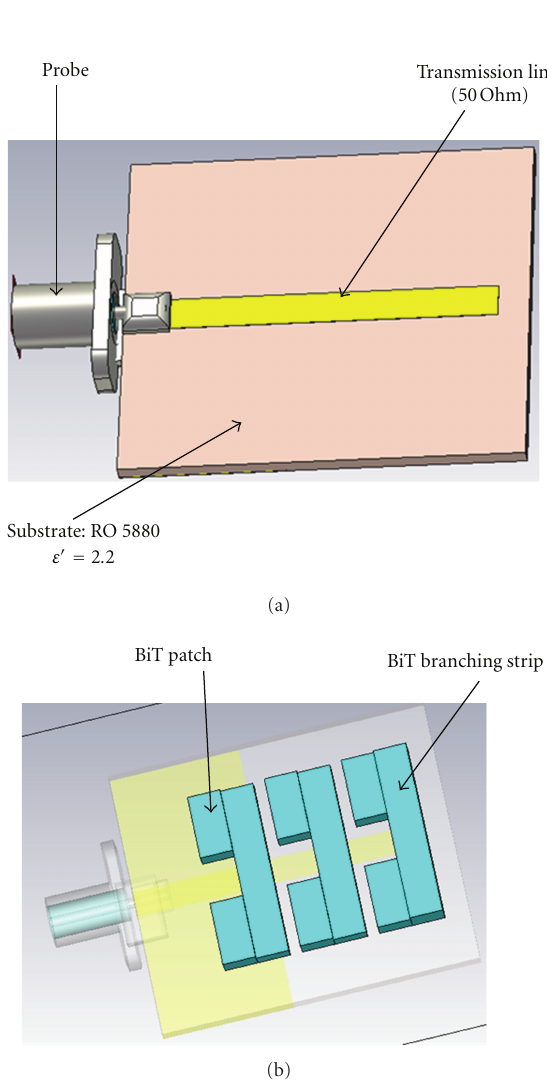
Figure 4: Configuration of the multilayers and its optimized dimensions, (a) first layer, (b) second layer.